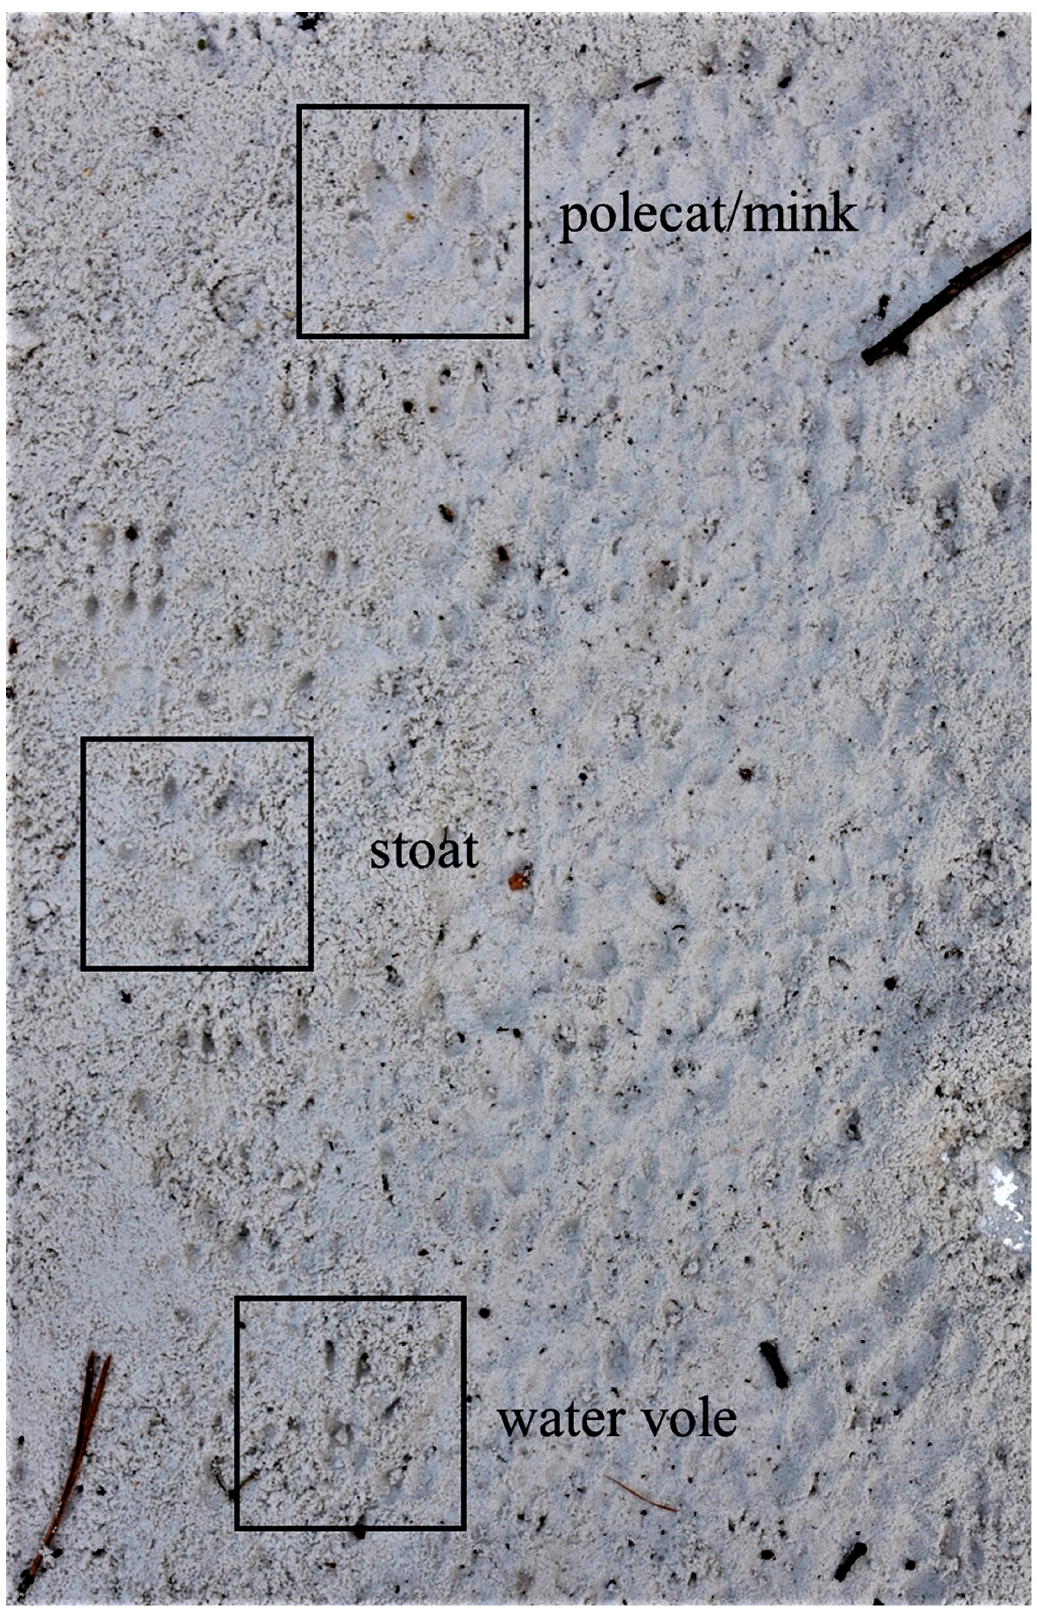
Figure 3. Example of a kinetic sand surface retrieved from a tracking tunnel. Three examples of single mammal tracks are indicated; 5 × 5 cm squares are given for comparison (photo by Z.